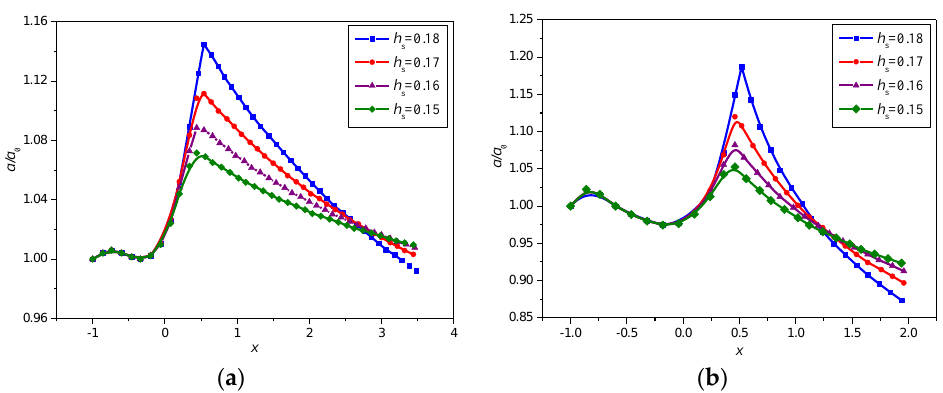
Figure 7. Validation of amplitude variation while ISWs propagating over slope bottom in regard to mesh sizes for the case a 0 /h 1 = 0.4 and h s = 0.18.